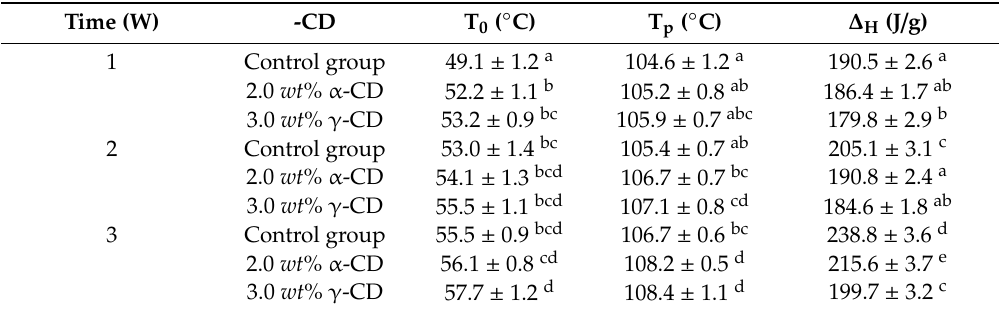
Table 4. E ff ects of the addition of 2.0 wt% α -CD and 3.0 wt% γ -CD on the enthalpy of prebaked bread samples that had been frozen for 1, 2, or 3